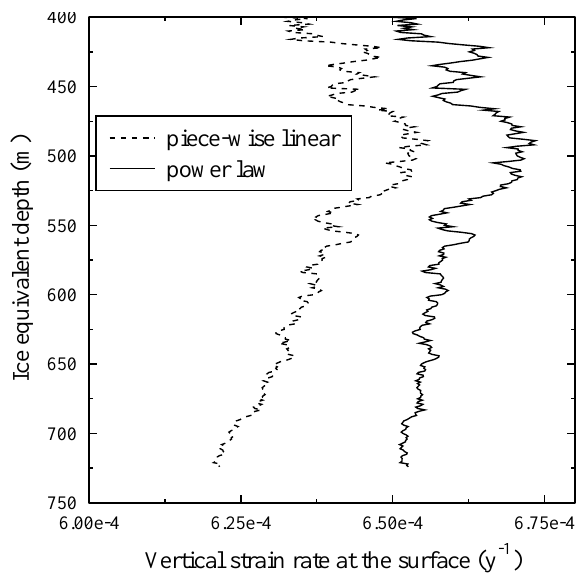
Figure 7. Inferred surface vertical strain rates from the piece-wise linear and power-law models. The surface strain rates are deter- mined from annual layer thickness data from a 100m depth interval centred on each ice equivalent depth value and the fixed long-term average annual snow accumulation rate specific to each